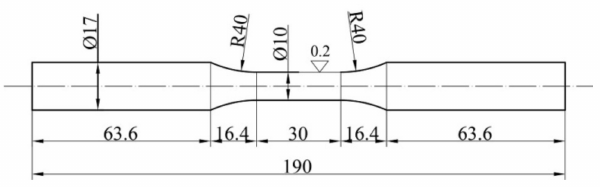
Figure 13. Test specimens dimensions.